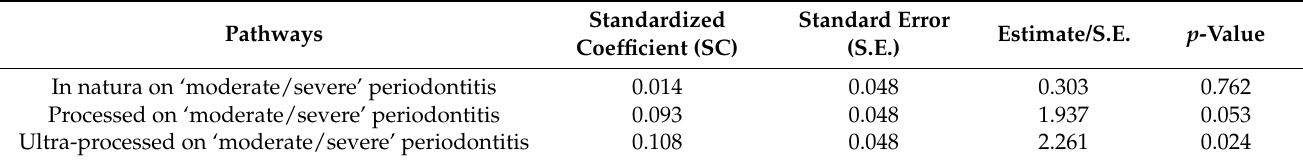
Table 3. Standardized effects between food consumption and moderate/severe periodontitis among adults enrolled in the 1982 Pelotas birth